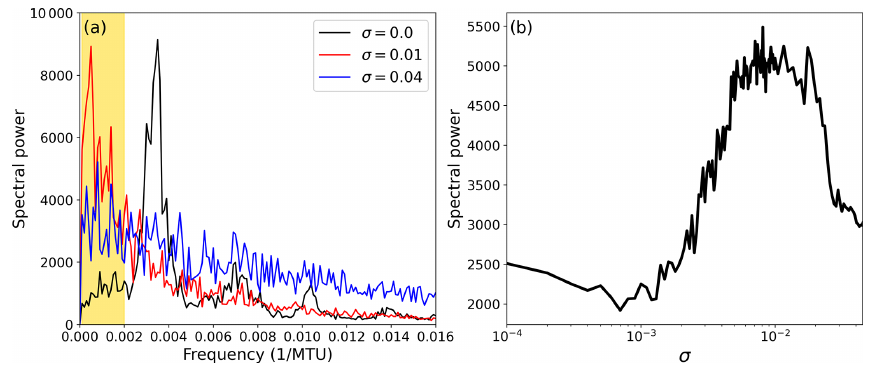
(cid:113) (cid:80) 2 , for three different strengths of stochastic forcing, σ . (b) The i x i